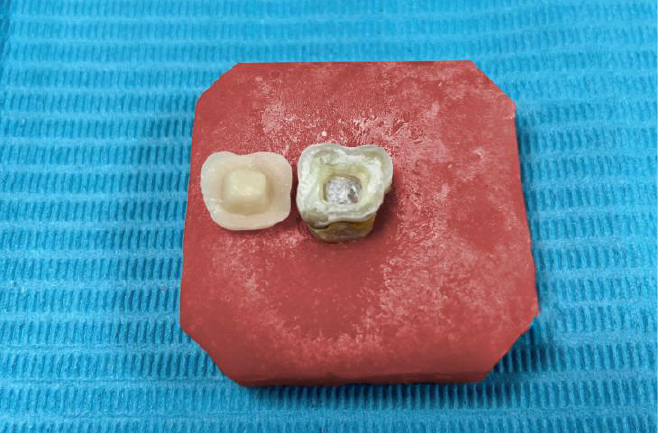
Figure 1. Abutment preparation for Conventional Endocrown design.